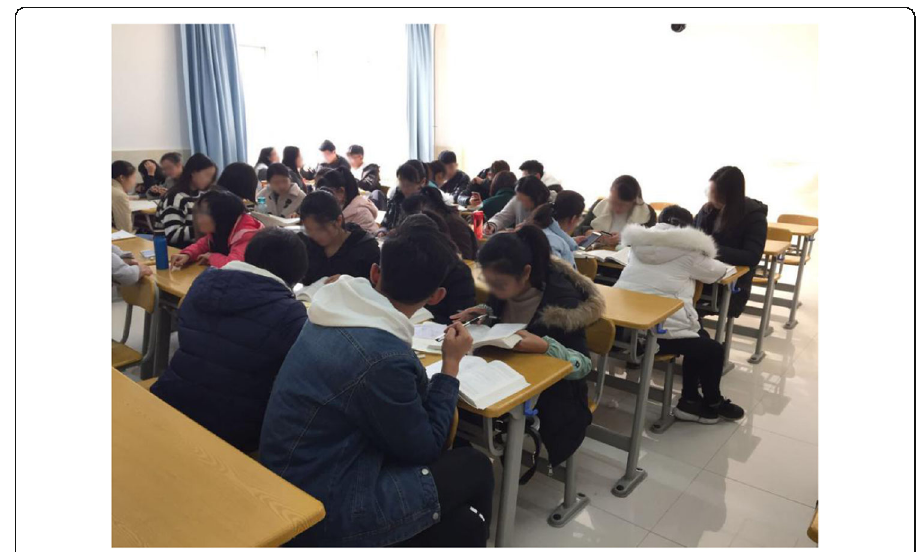
Fig. 3 Group discussion in the face-to-face classroom. In the first 45 min of face-to-face classroom teaching, each group of students to discuss the problems they can ’ t solve when they watch videos and do online exercises before class. Also, each group has a team leader who is responsible for group discipline